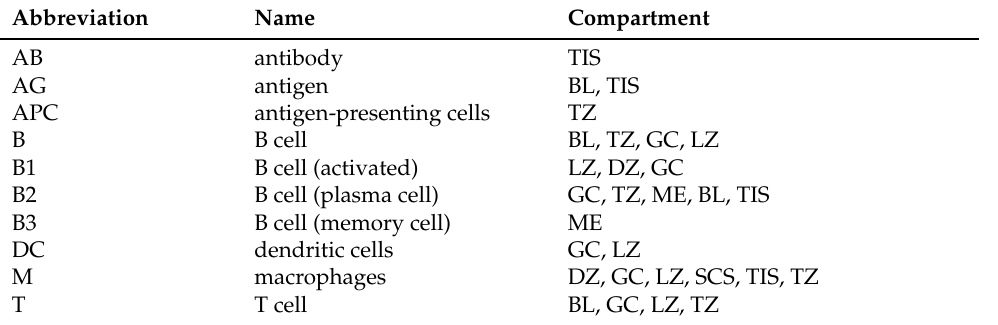
Table 2. Abbreviations for cells and antigen.